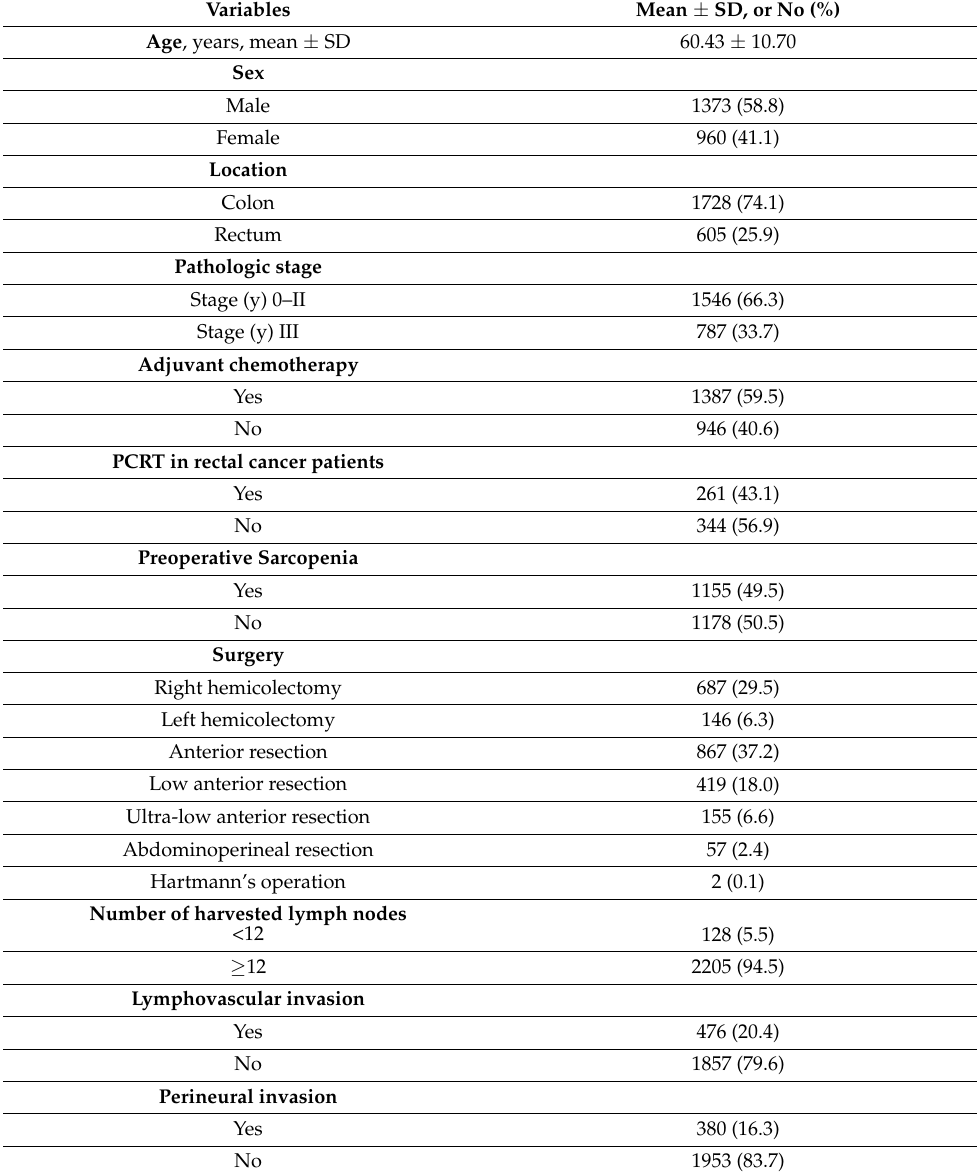
Table 1. Clinical characteristics of the study